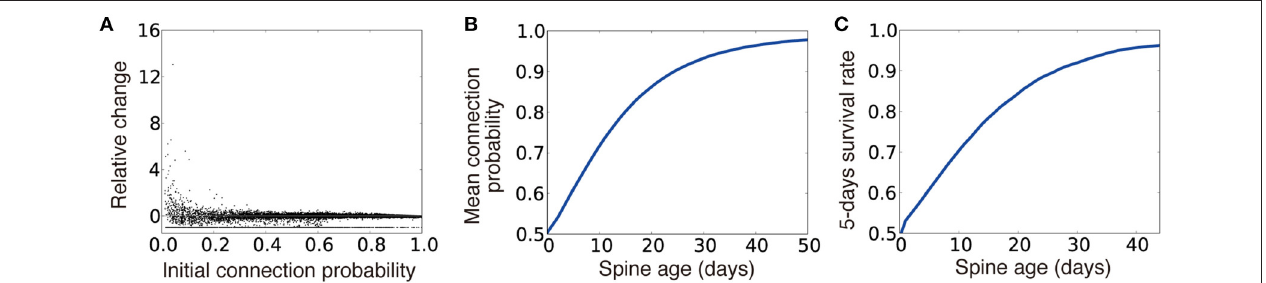
FIGURE 7 | Spine dynamics of the approximated dual Hebbian model. (A) Relative change of connection probability in 10 5 time steps. If the initial connection probability is low, the relative change after 10 5 time steps has a tendency to be positive, whereas spines with a high connection probability are more likely to show negative changes. The line at the bottom represents eliminated spines (i.e., relative change 1). (B,C) Relationships between spine age and the mean connection = − probability (B) and the 5-days survival rate (C) . Consistent with the experimental results, survival rate is positively correlated with spine age. Five days survival rate was calculated by regarding 10 5 time steps as 1